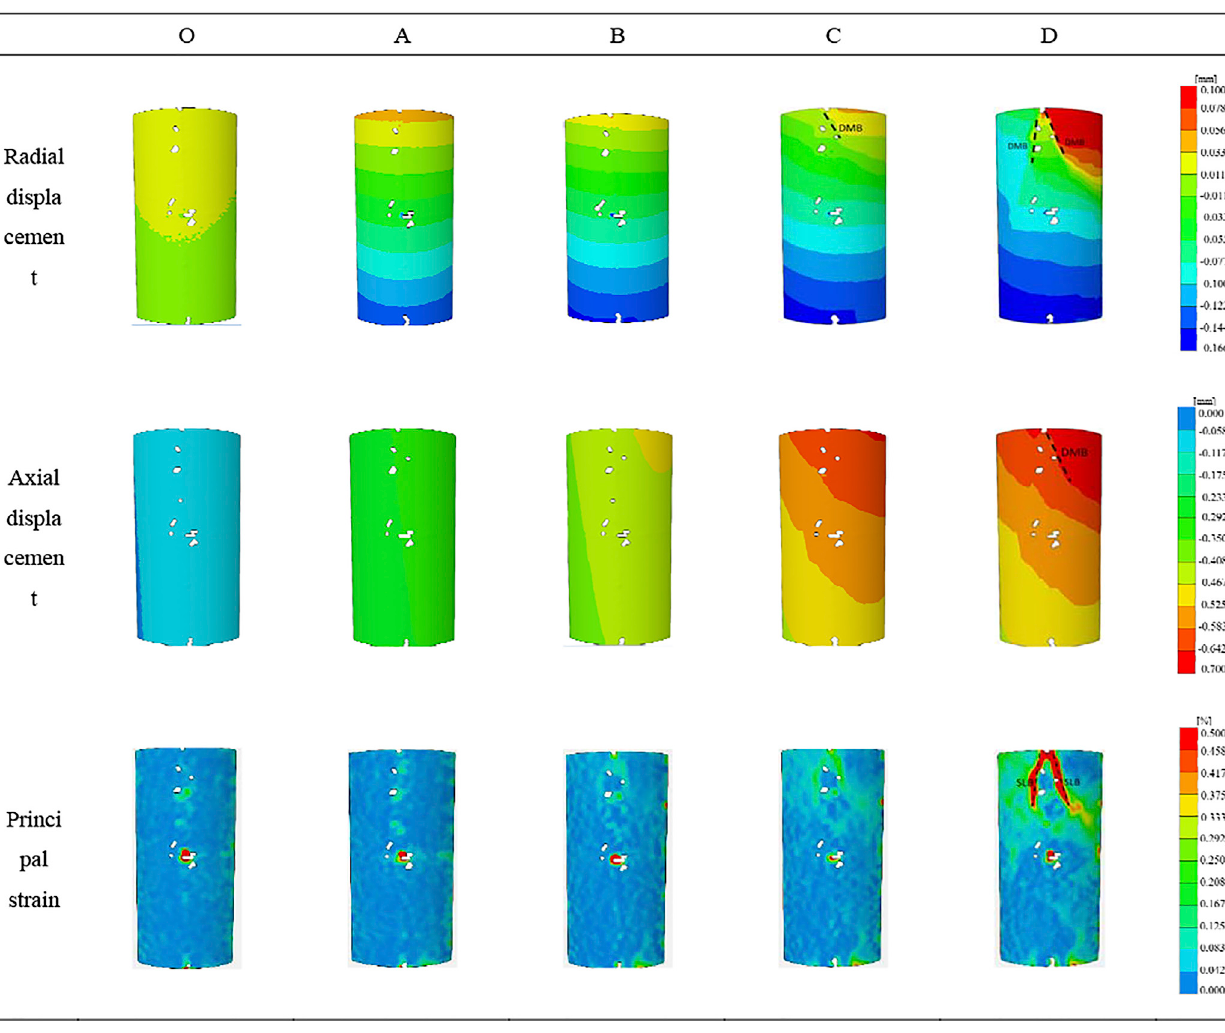
TABLE 2 | Displacement and strain development of rock specimen